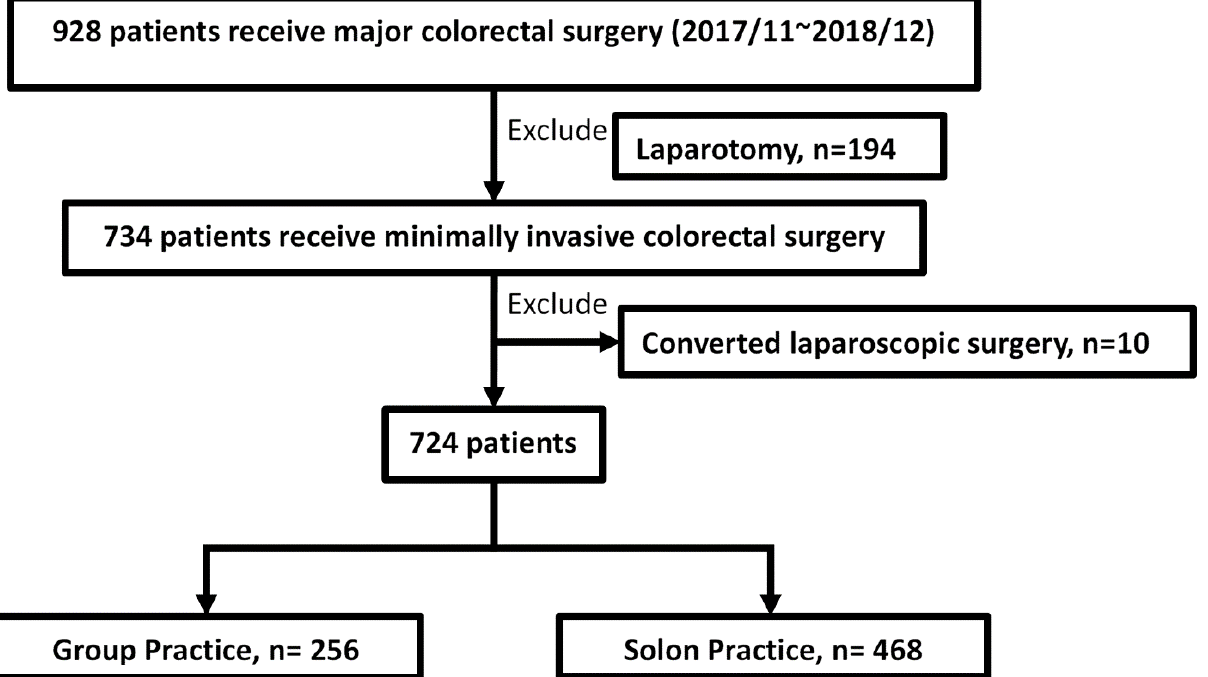
Figure 1. Flow chart of the patient enrolment process for this study cohort.